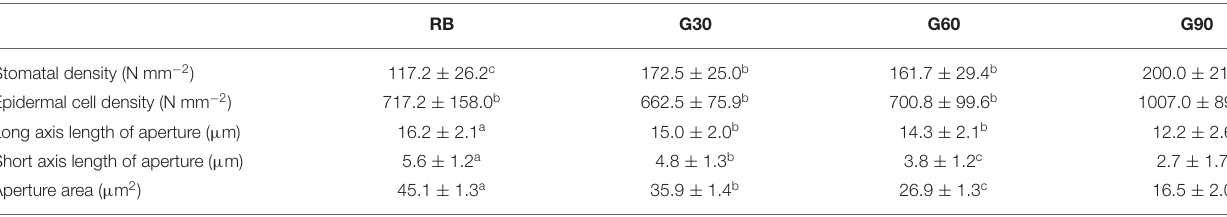
TABLE 2 | Effects of green light on stomatal characteristics of